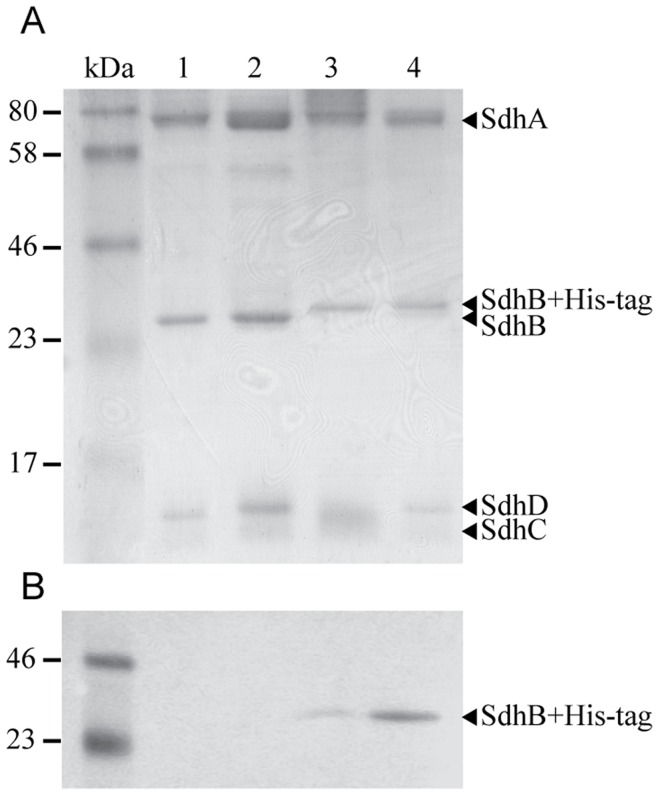
SDS-PAGE (A) and Western blot (B) analysis of purified complex II from T. thermophilus.
Lanes: 1– native cII, 2– wt-rcII, 3– rcII-SdhB-His6, 4– rcII-His8-SdhB.